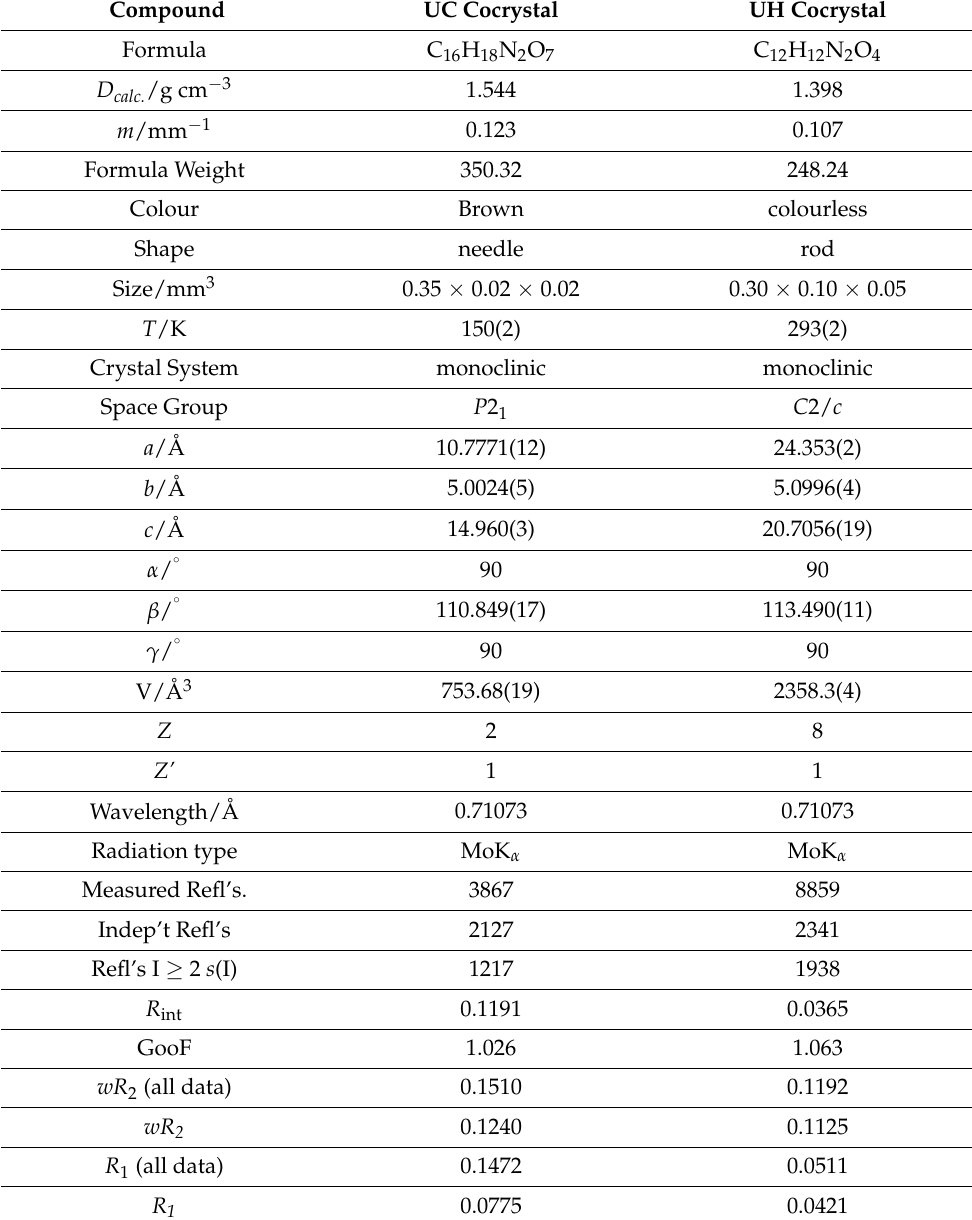
Table 1. SC-XRD crystallographic data for the UC and UH